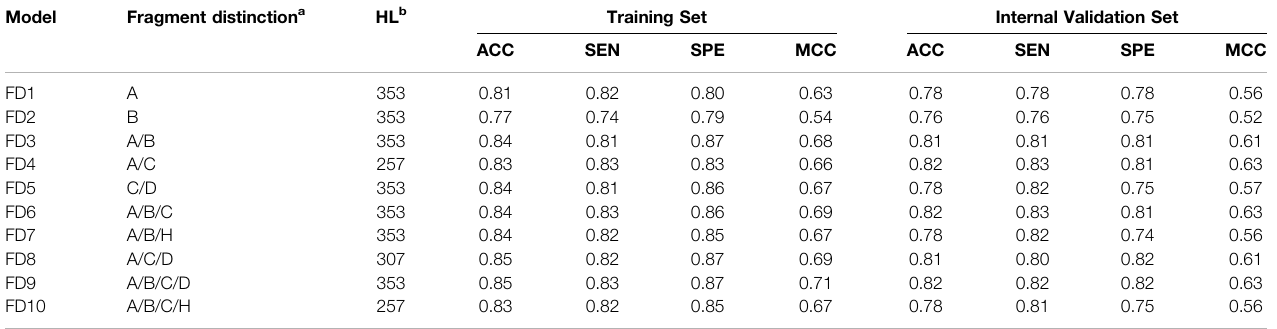
TABLE 3 | Performance of the PLS-DA models based on different fragment